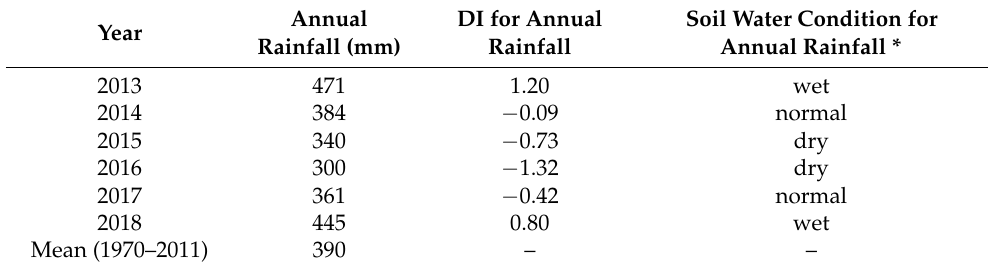
Figure 1. Monthly precipitations in the years from 2013 to 2018 and 1997–2011 average for the lucerne-to-crop conversion treatment of the study at the Rainfed Agricultural Experiment Station of Gansu Agricultural University. Table 2. Annual rainfall from 2013 to 2018 and average of 1997–2011, drought index (DI), and soil water condition for the experimental years at the Rainfed Agricultural Experimental station of Gansu Agricultural University.